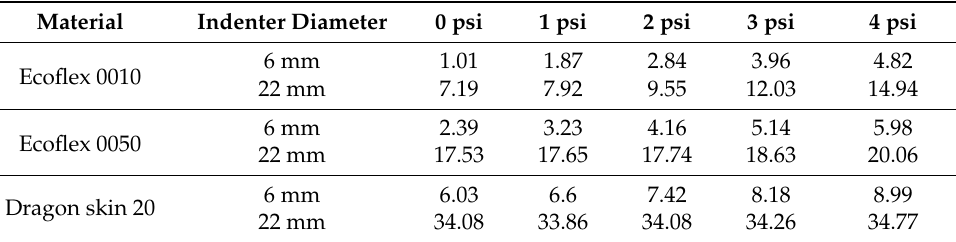
Figure 6. Test force-displacement results of different durometer dome samples: ( a ) Ecoflex 0010, ( b ) Ecoflex 0050, and ( c ) DragonSkin 20 when 6 mm diameter indenter was applied. Test results of different durometer dome samples: ( d ) Ecoflex 0010, ( e ) Ecoflex 0050, and ( f ) DragonSkin 20 when 22 mm diameter indenter was applied. Table 2. Maximum force (N) measurement in 6 and 22 mm indention tests for each material and pressure condition .